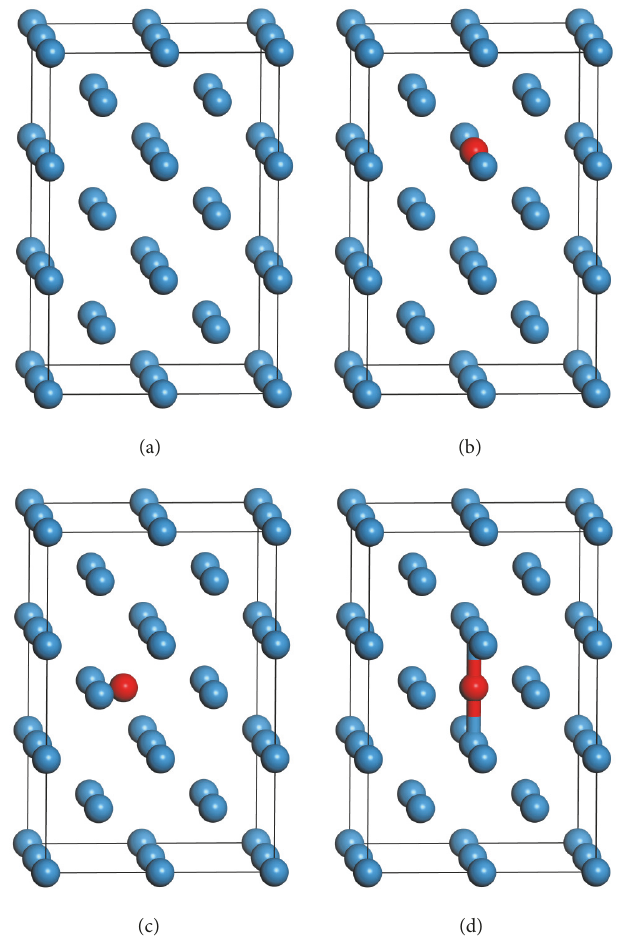
Figure 1: The crystal structure of BCC W. The blue balls stand for the tungsten atoms, and the red ball stands for the H atom or He atom. A pure W supercell (a) and a W supercell contain a H atom or He atom in the substitutional site (b), tetrahedral site (c), and octahedral site